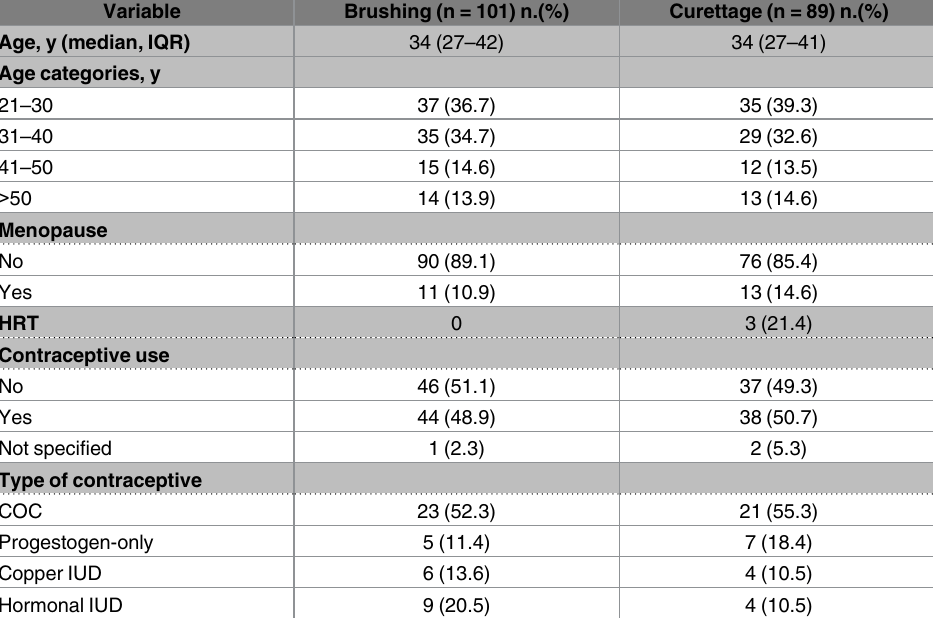
Table 1. Patient characteristics by study